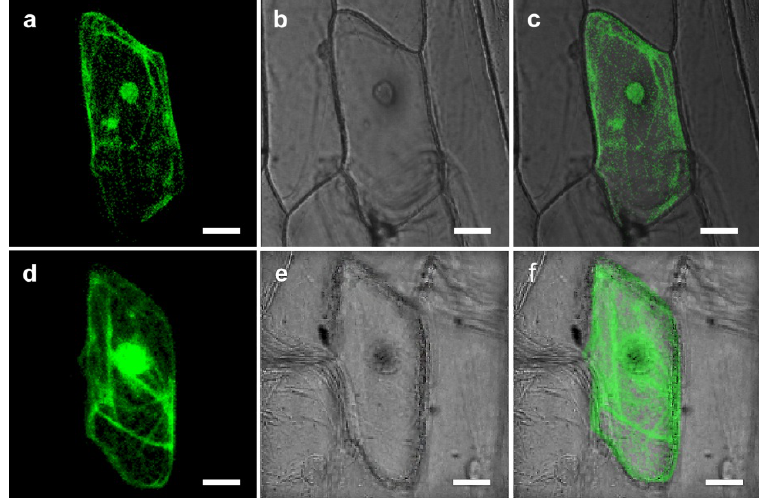
Figure 2. Sub-cellular localization of CgHSP70 in transiently transformed onion epidermal